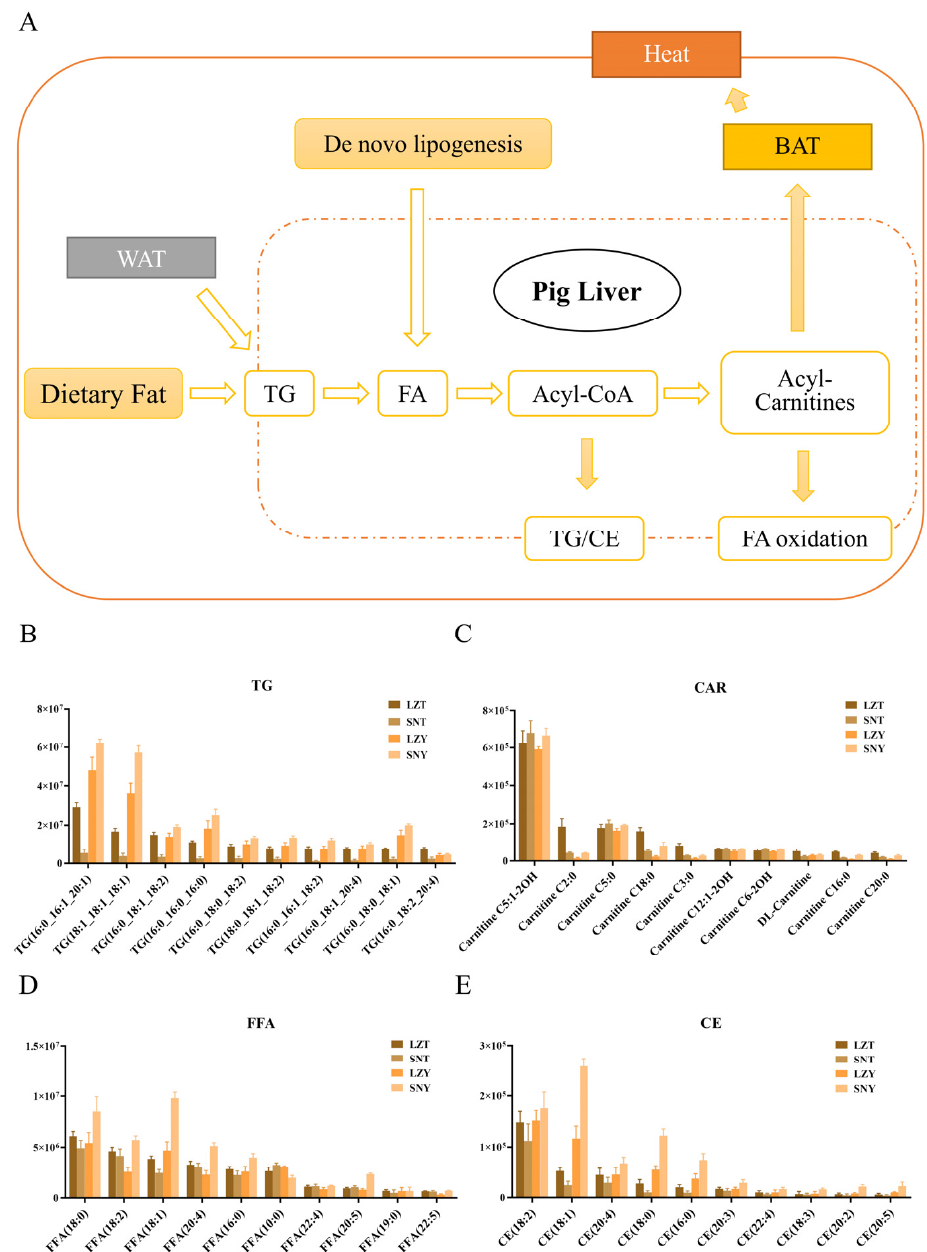
Figure 4. Complex lipid metabolism in the liver of Tibetan and Yorkshire pigs. ( A ) Schematic diagram of the lipid metabolism processes occurring in the pig liver. ( B ) Top 10 abundant triglycerides (TGs) in the pig liver. ( C ) Top 10 abundant carnitines (CARs) in the pig liver. ( D ) Top 10 abundant free fatty acids (FFAs) in the pig liver. ( E ) Top 10 abundant cholesteryl esters (CEs) in the pig liver.